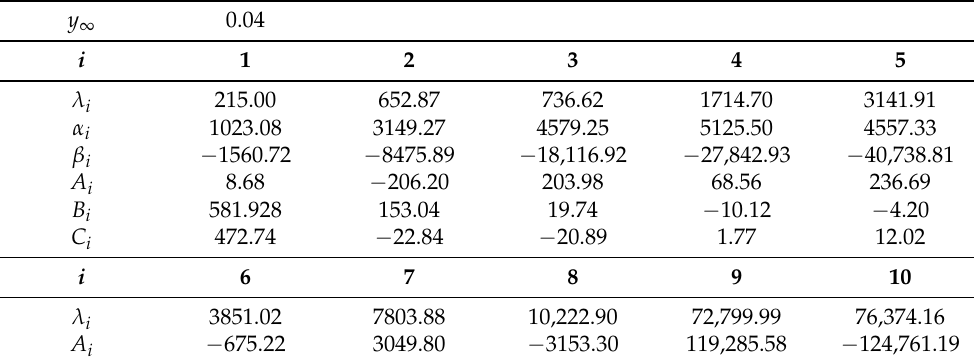
Table A3. Values of y ∞ , λ i , α i , β i , A i , B i and C i for